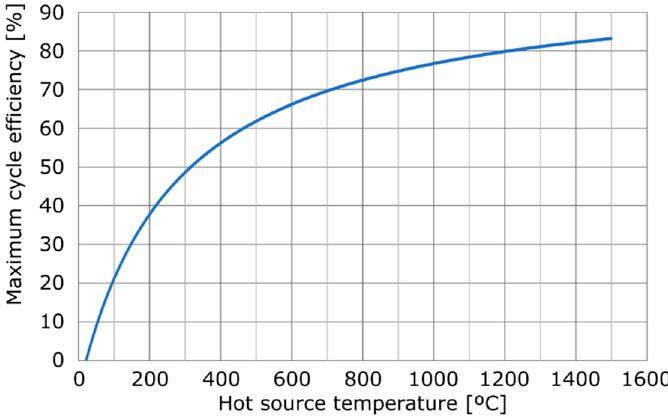
Figure 4. Carnot cycle efficiency as a function of the hot source temperature for a cold sink temper- ature of 20 °C.